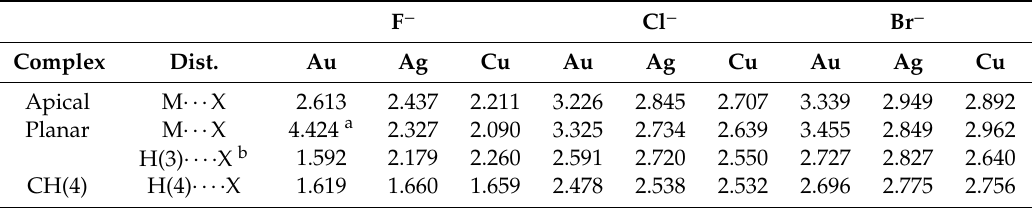
Table 4. Intermolecular M ··· X − and H ··· X − distances (Å) in the 1:2 complexes. F − Cl